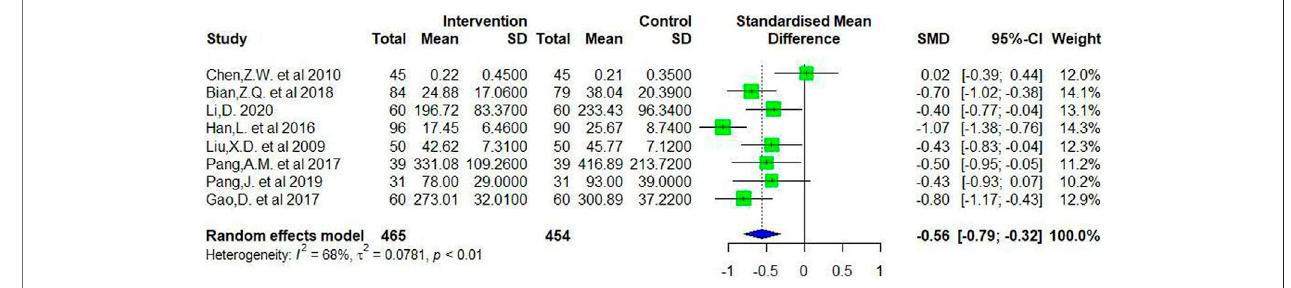
FIGURE 4 | Forest plot and meta-analysis of anti-CCP.